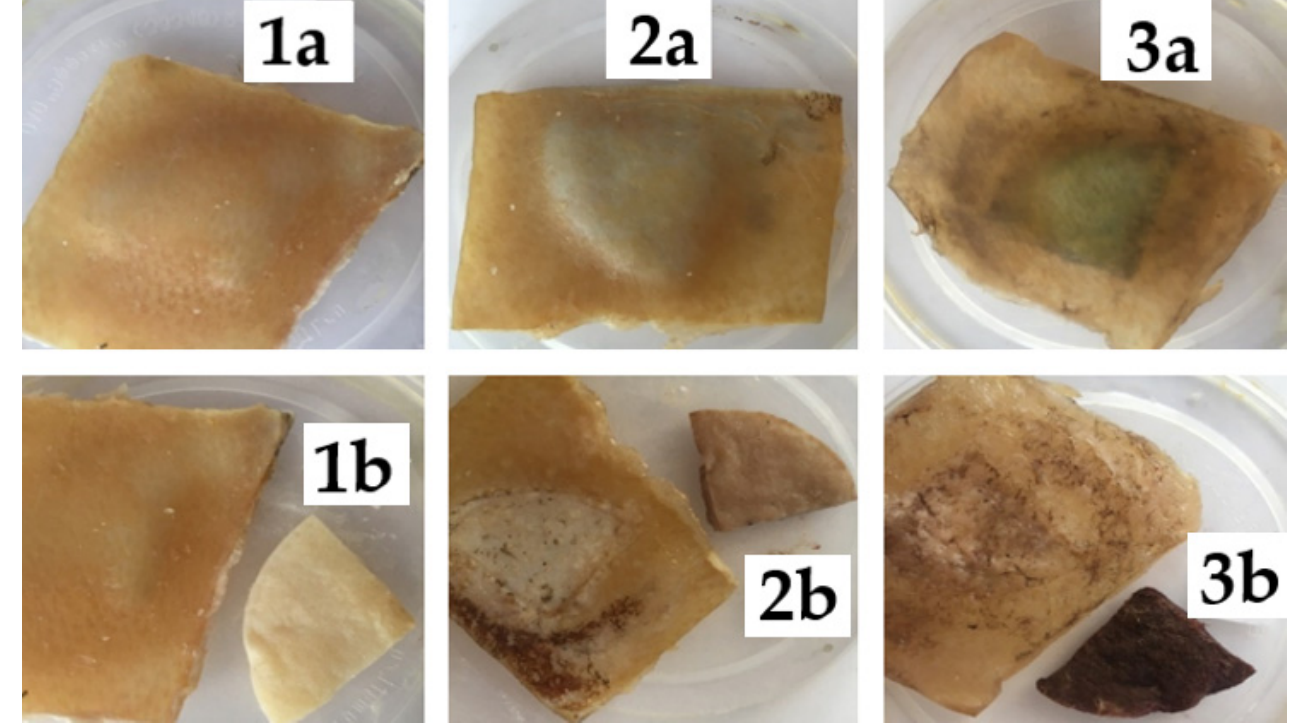
Figure 3. Cotton pad impregnated with silver chloride sol suspension in sweat-simulating solution after 5 days’ storage under pig skin. Sample 1: under the skin in a dark place ( 1a ); the disc sector color has not changed ( 1b ). Sample 2: under the skin in diffused sunlight ( 2a ), the disc sector has darkened ( 2b ). Sample 3: under the skin in direct sunlight ( 3a ), the disc sector has significantly darkened ( 3b ).